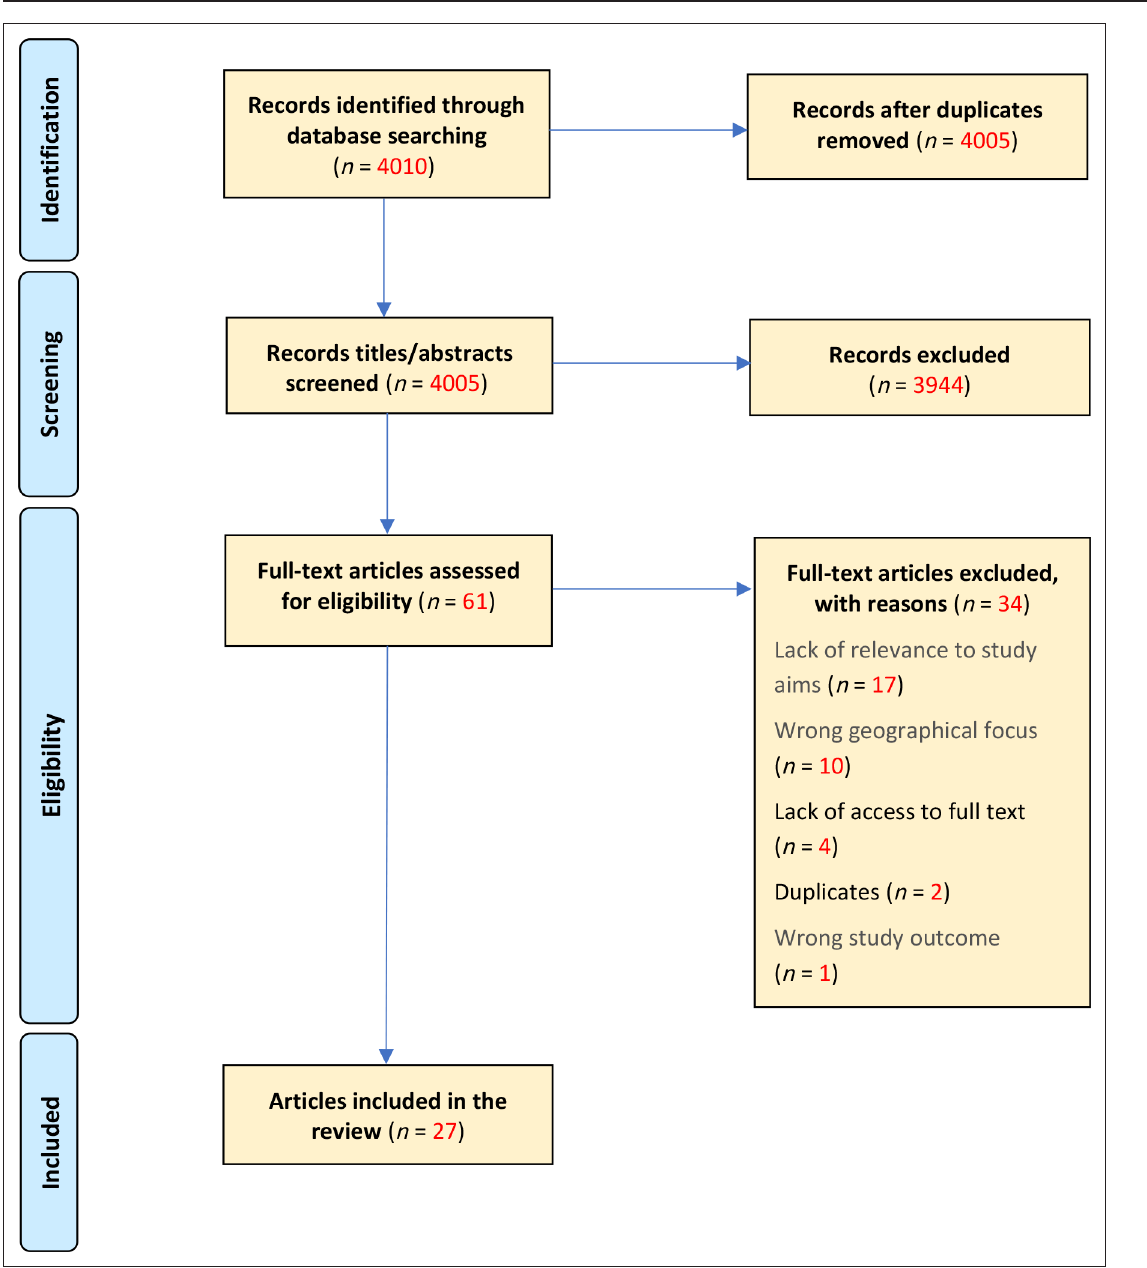
Figure 1 Adapted PRISMA flow chart. Explaining the study’s documentary screening and inclusion and exclusion